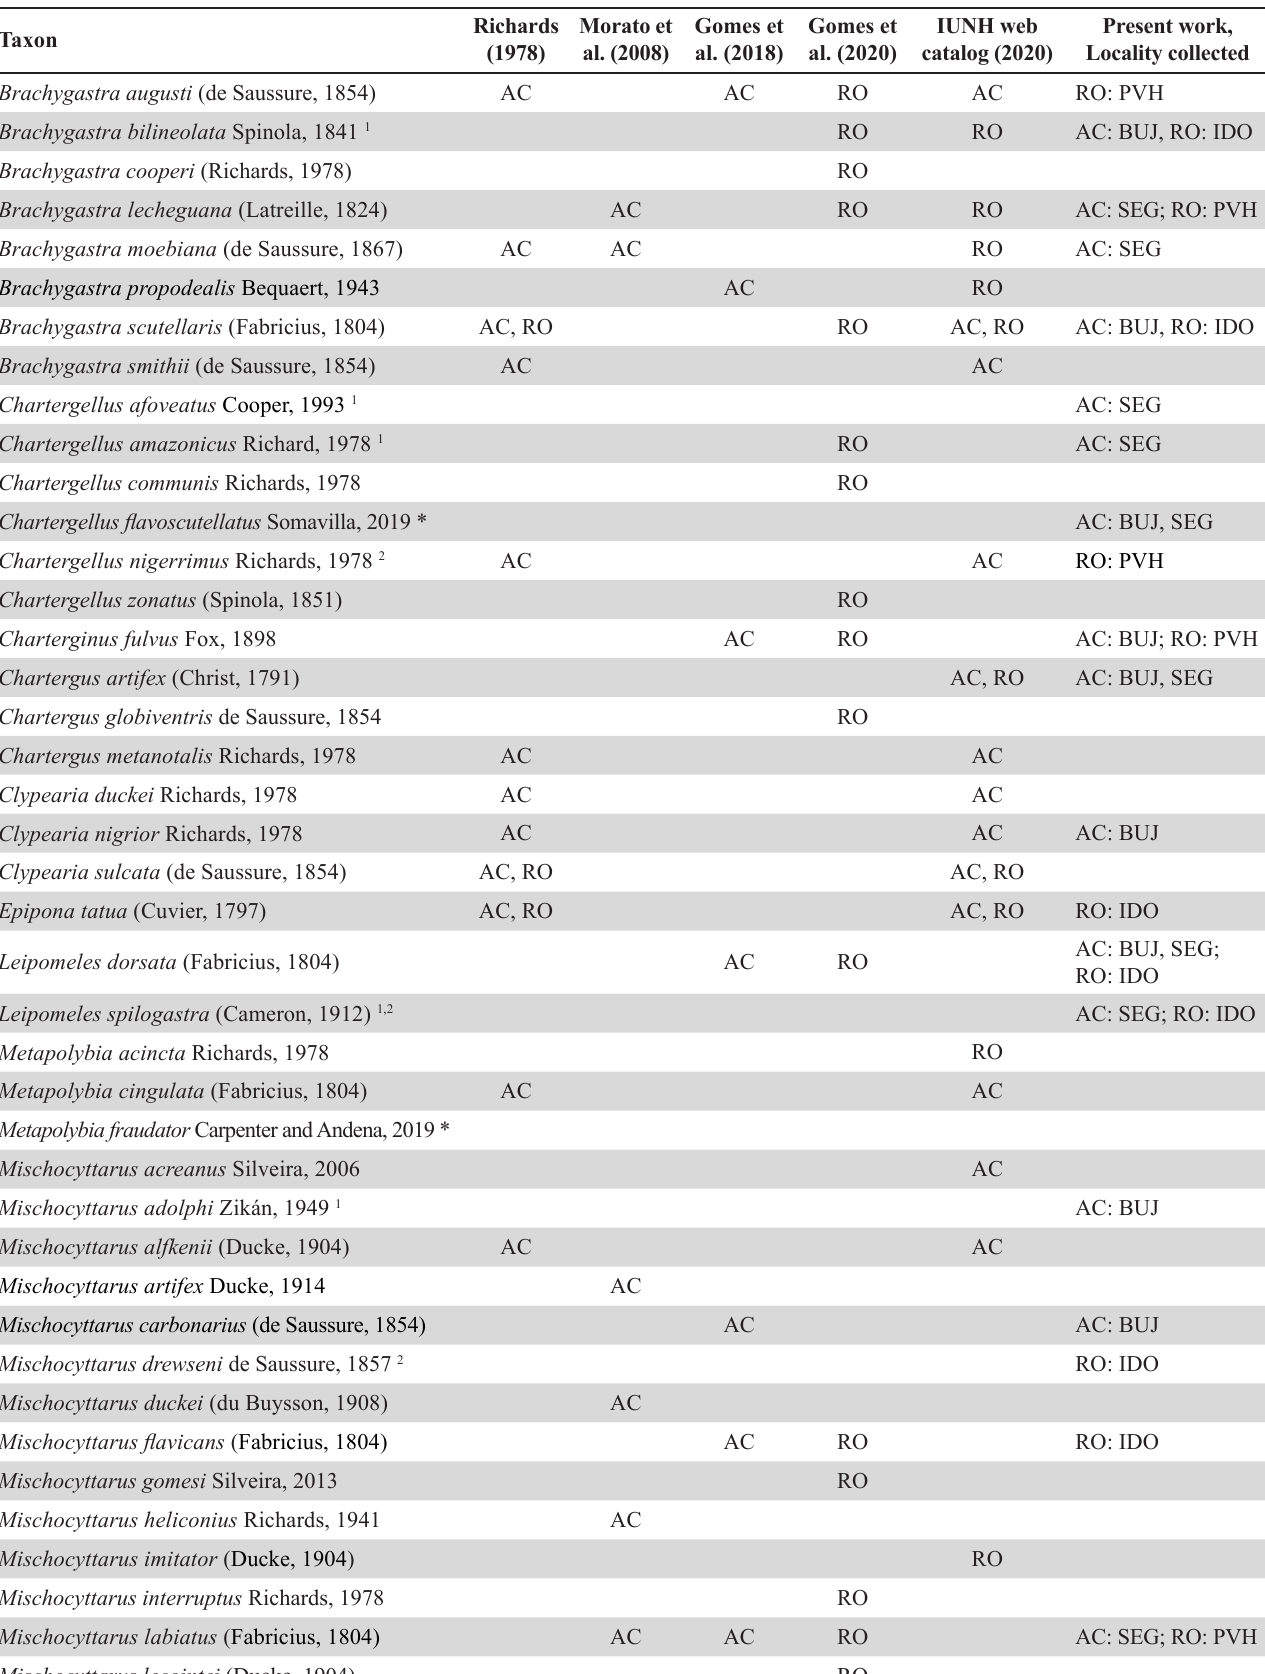
Table 1 . Species of social wasps from Acre and Rondônia states, listed by Richards (1978), Morato et al. (2008), Gomes et al. (2018), distribution record for Acre; 2 new distribution records for Rondônia; * distribution records only in the descriptions of the species.